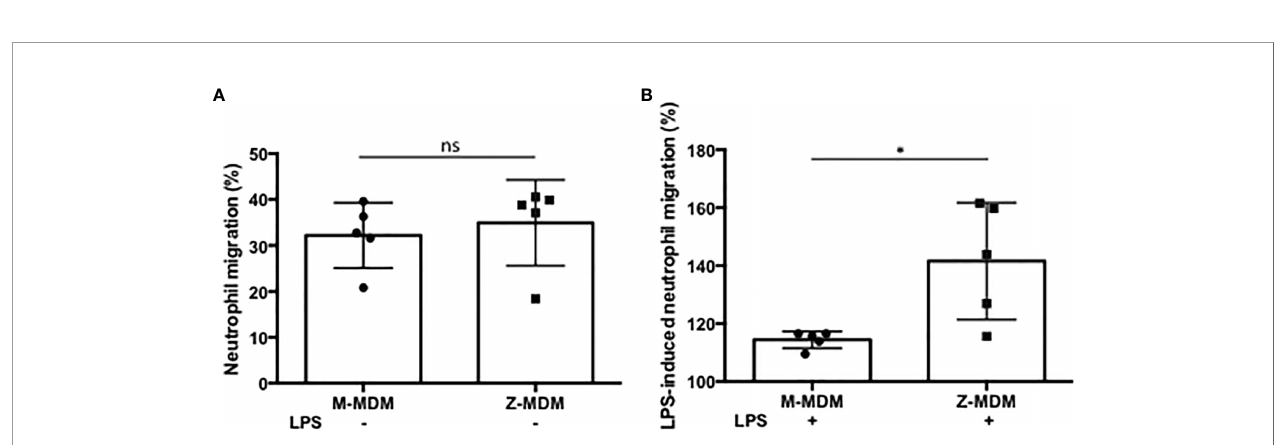
FIGURE 4 | The effect of AAT on LPS-induced neutrophil chemotaxis. MDMs were incubated with LPS (10 ng/ml) overnight. To examine the ability of AAT to regulate neutrophil transmigration, conditioned media of M- and Z-MDMs were collected and placed in the bottom chamber of transwell system. Freshly isolated neutrophils were placed in the top chamber of the transwell system. The number of neutrophils migrated to the bottom layer were counted after 30 min. (A) The number of neutrophils in the bottom layer was divided by the total number of neutrophils to calculate the migration rate of control MDMs. (B) To calculate the migration rate after LPS treatment, the migration rate of control MDM was set to 100%, and the migration rate of LPS-treated MDM was normalized to control for each individual; n=5. *Denotes statistical signi fi cance (p-value < 0.05) according to two-tailed Student ’ s t-test.